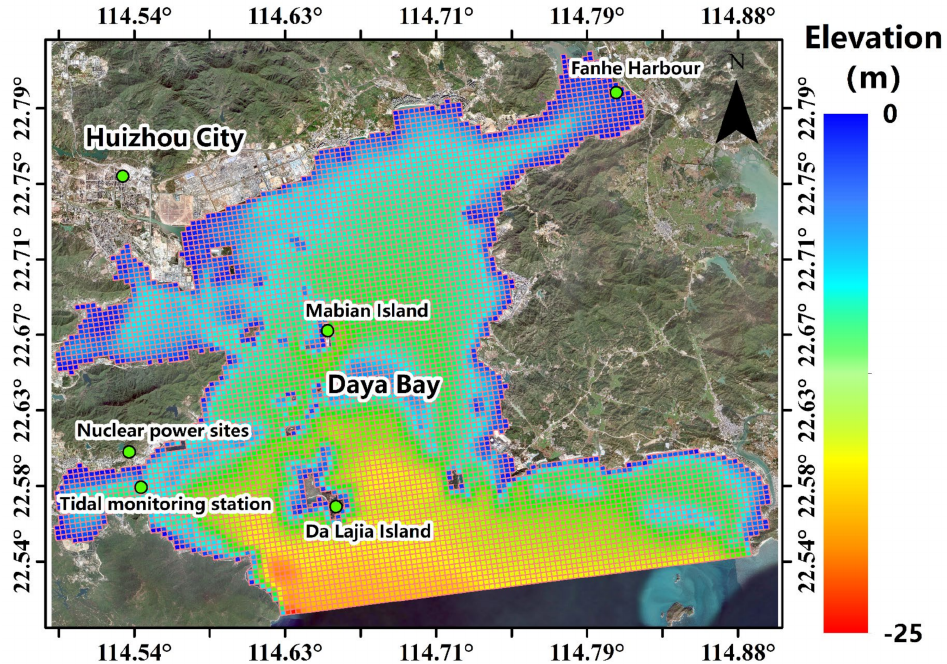
Figure 1. Computational domain and monitoring